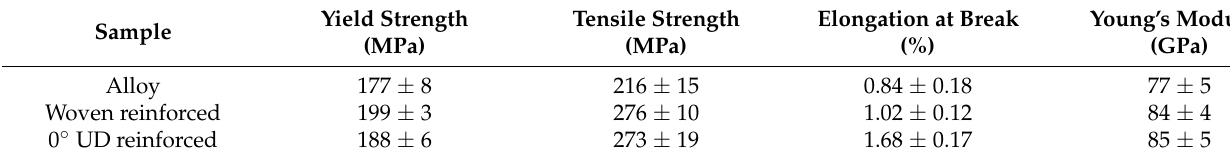
Table 2. Results of the mechanical properties.